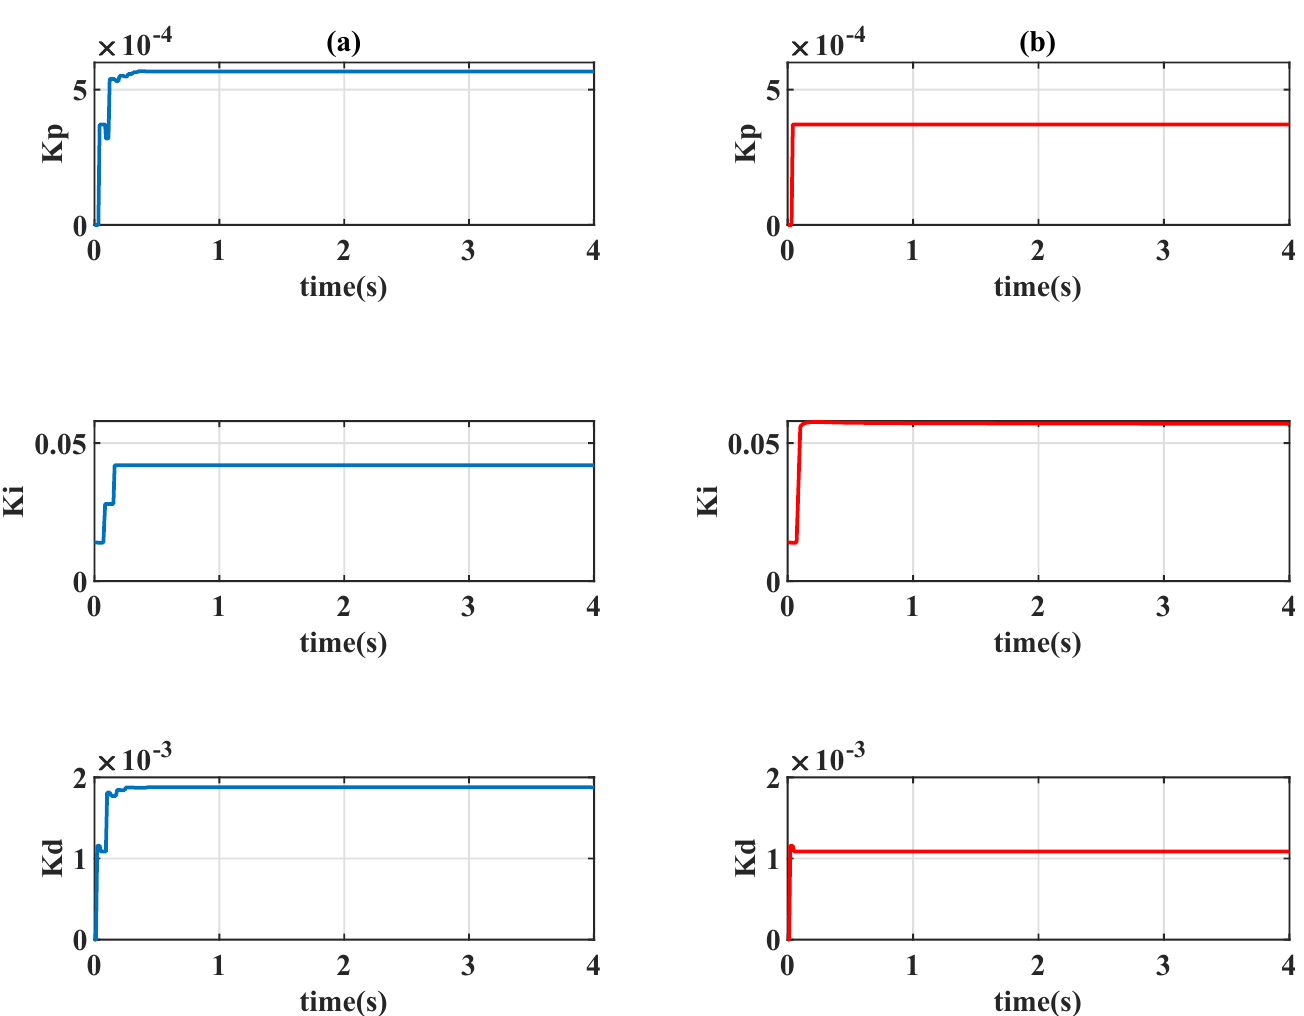
( z ) . ( z ) ; ( b ) Sarsa C e Q S